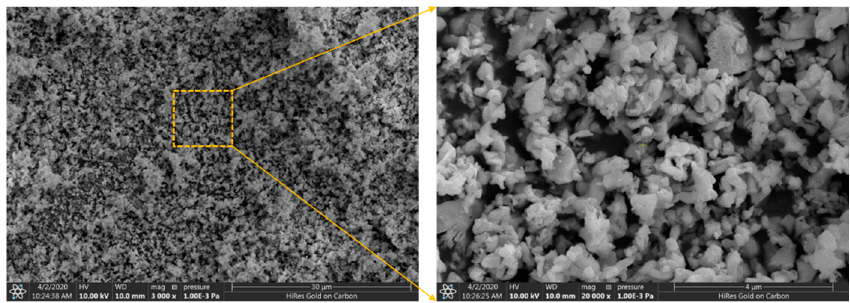
Figure 1. The scanning electron microscope image of Nd 2 O 3 .